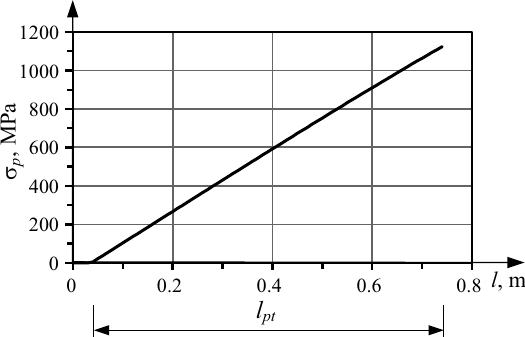
Fig. 4. Calculated prestressing strand stress profile along the transfer length including all prestress losses